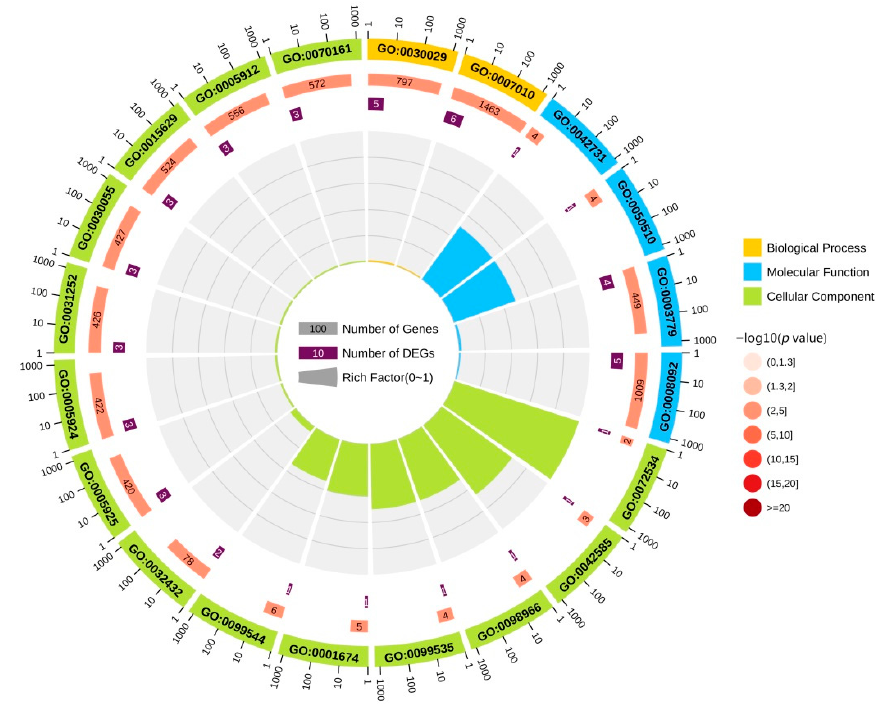
Figure 3. GO functional analysis of DEGs. The yellow area in the figure represents the biological process of DEG. The blue area in the figure represents the molecular function of the DEGs. The green area in the figure represents the cellular component of the DEGs.